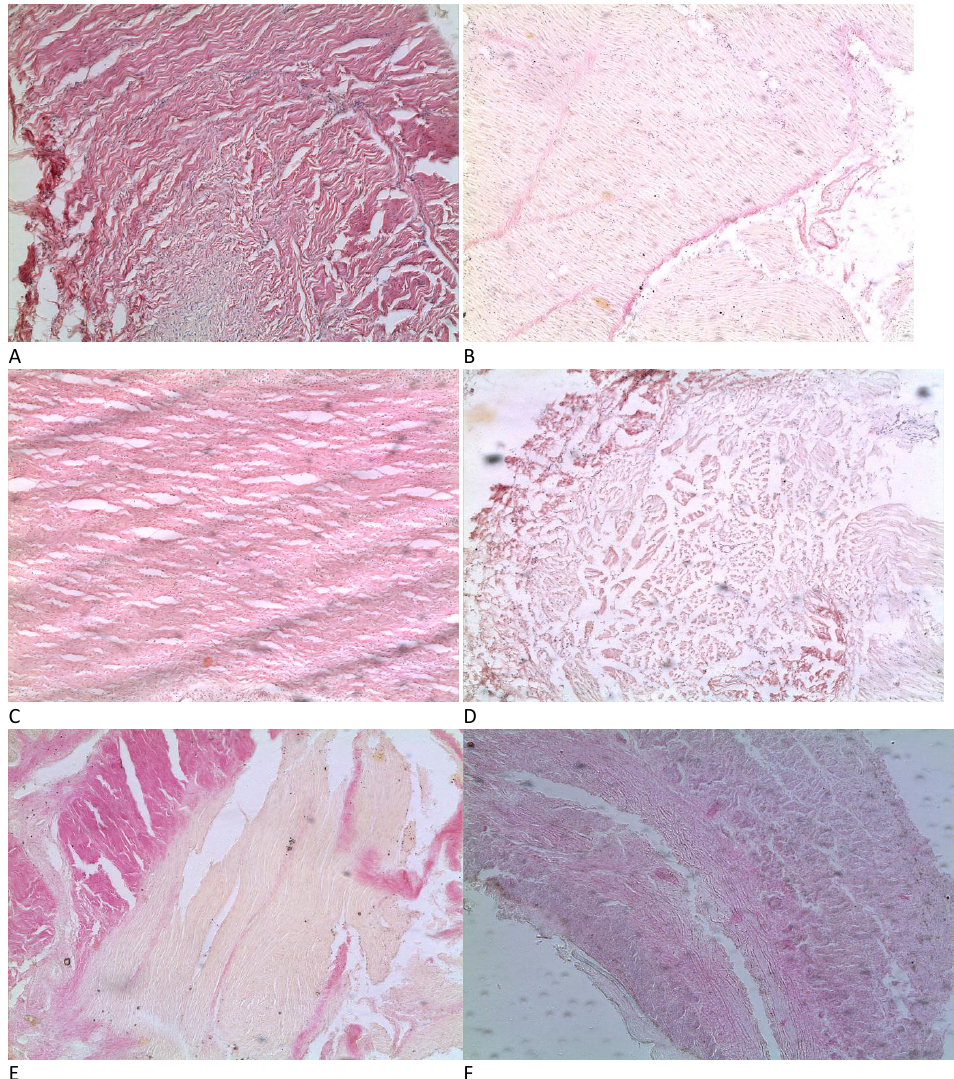
Figure 2. Microstructure of fermented hen gizzards (staining with picrofuxin according to Van Gieson). ( A ) control sample in the start time; ( B ) fermented control sample; ( C , E ) fermented test sample with BLC; ( D , F ) fermented test sample with Propionix LCSC (magnification × 100). The microslides of the combs of control samples are represented by skin fragments with a thin stratum corneum. The surface of the skin is folded, covered with a thin layer of epidermal cells (Figure 3(A1, arrow 1)). In the subepidermal layer, a large number of lacunae-type blood vessels are visible (Figure 3(A1, arrow 4)). Cells and their nuclei are clearly visible, with good acceptance of histological dyes. The extracellular matrix is represented by randomly located collagen fibers. In the deep layers, stratums of adipose tissue are visible, separated by thick connective tissue septa, consisting mainly of compactly packed collagen fibers (Figure 3(A1, arrows 2, 3)). The cellular composition is dominated by mature fibroblasts, against which tissue macrophages, lymphoid cells and tissue basophils are determined in small quantities (Figure